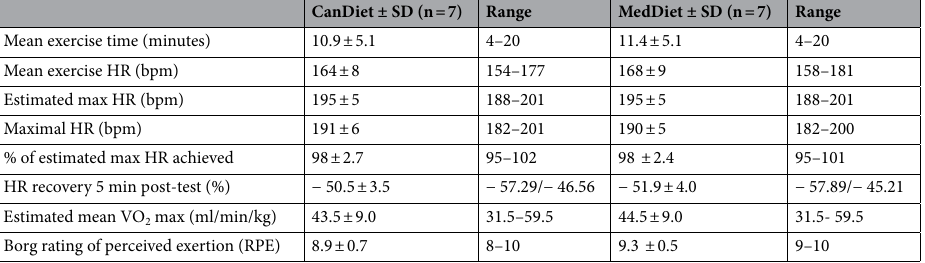
Table 3. Aerobic measurements after CanDiet and